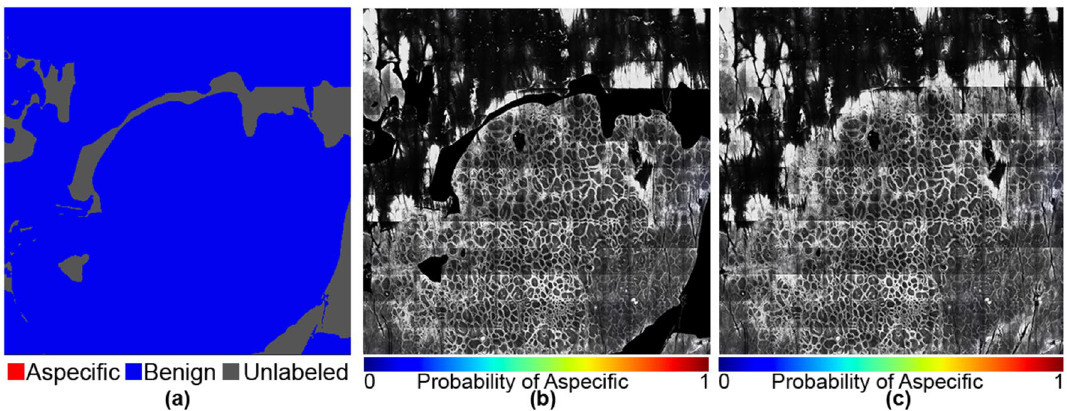
Figure 10. An example with no aspecific patterns. The mask and the heat map images are generated using OpenCV 4.5.1.48 (https ://pypi.org/proje ct/openc v-pytho n/) in Python 3.7.4 (https ://www.pytho n.org/downl oads/relea se/pytho n-374/). The images and the legends are put together using Photoshop CC 2018 (https :// prode signt ools.com/adobe -cc-2018-direc t-downl oad-links